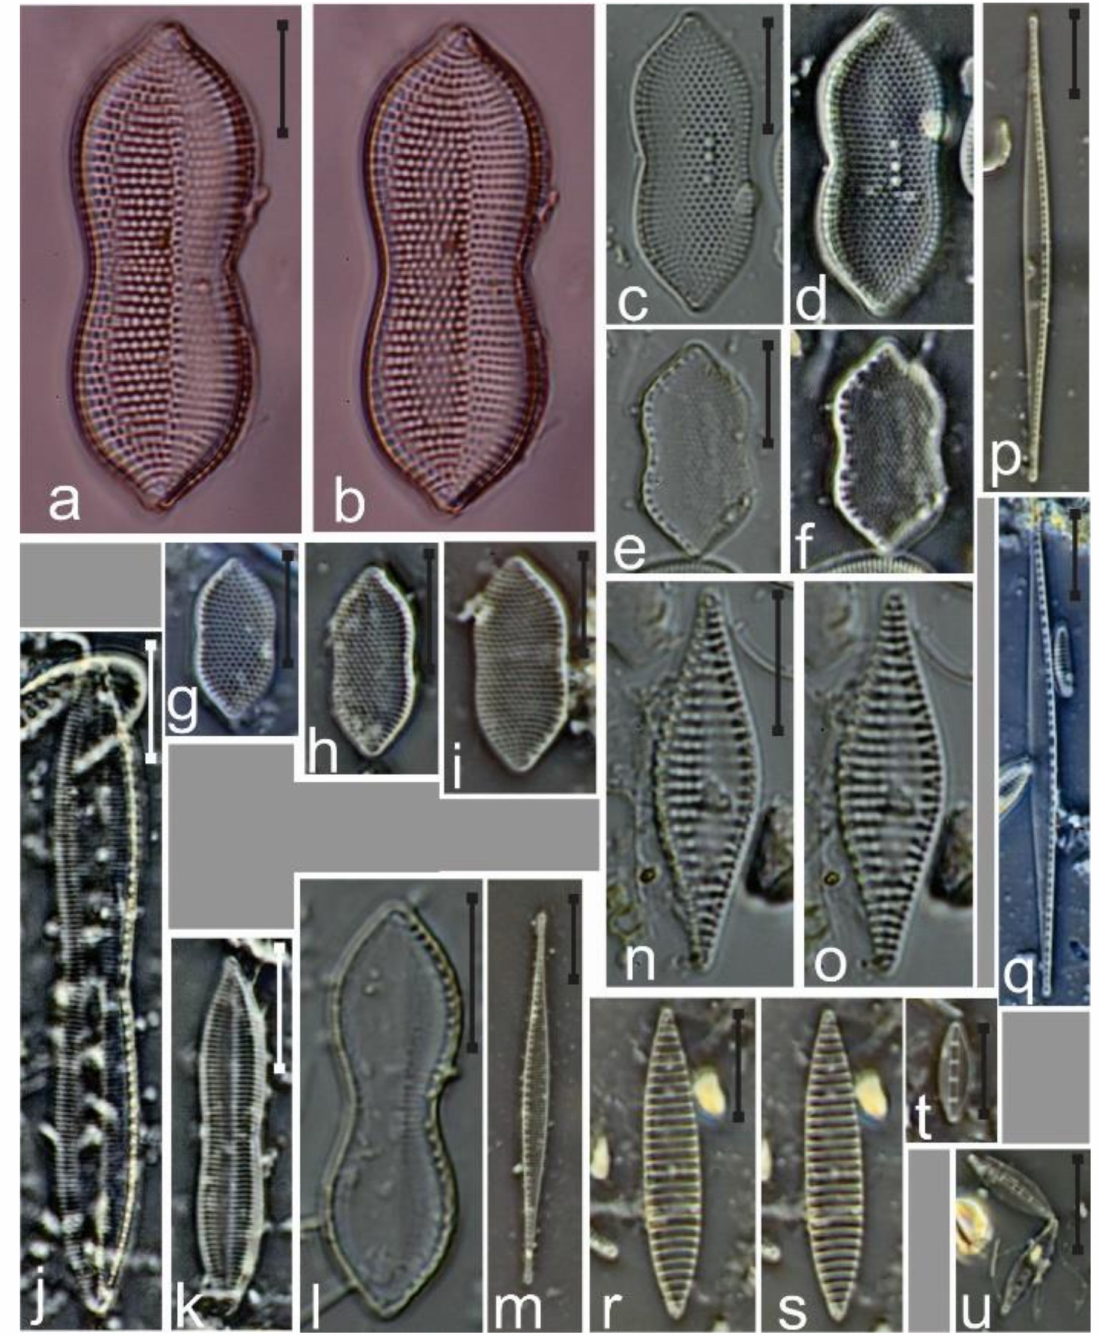
Figure43. ( a – d , g , h ) Tryblionellacoarctata ; ( e , f , i ) T.bathurstensis ; ( j , k ) T.hungarica ; ( l ) Nitzschiacarnicobarica ; ( m , p , q ) N. gracilis ; ( n , o ) Tryblionella lanceola ; ( r , s ) Nitzschia sicula ; ( t , u ) N. incrustans . Scale bar = 10 µ